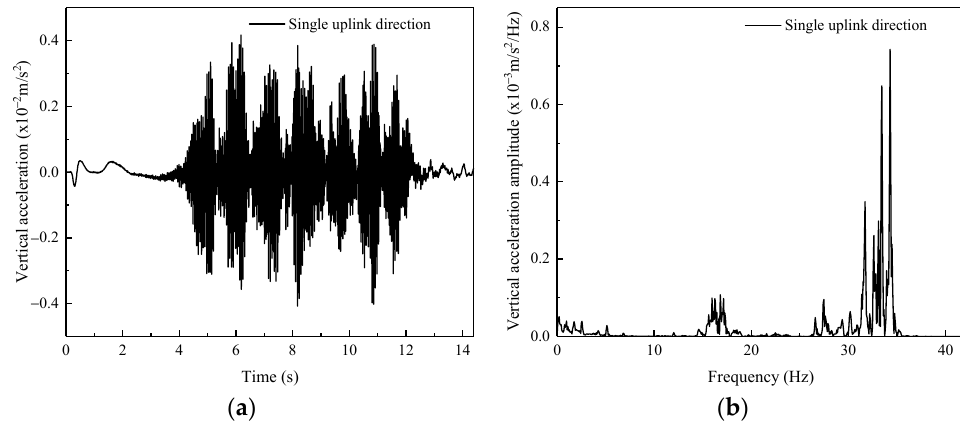
Figure 13. Vertical vibration at point O during the uplink operation. ( a ) Time history of dynamic acceleration; ( b ) acceleration amplitude-frequency.